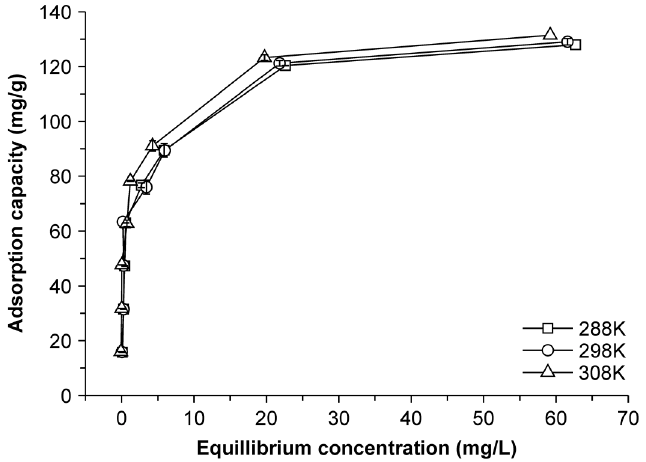
Figure 4. Effect of temperature on the Cu(II) adsorption properties of NMBCs.